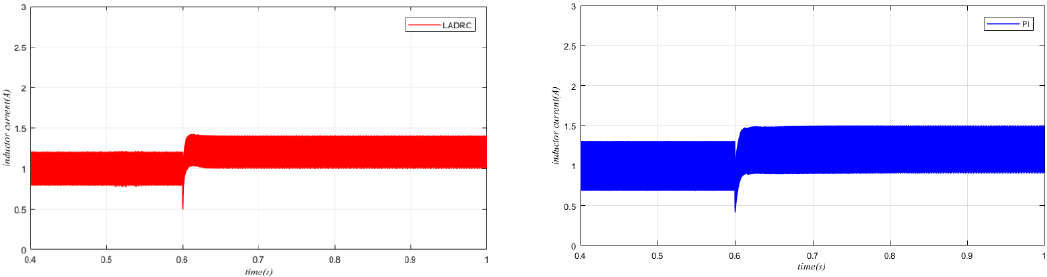
Figure 8. Output voltage responses in Case 1.